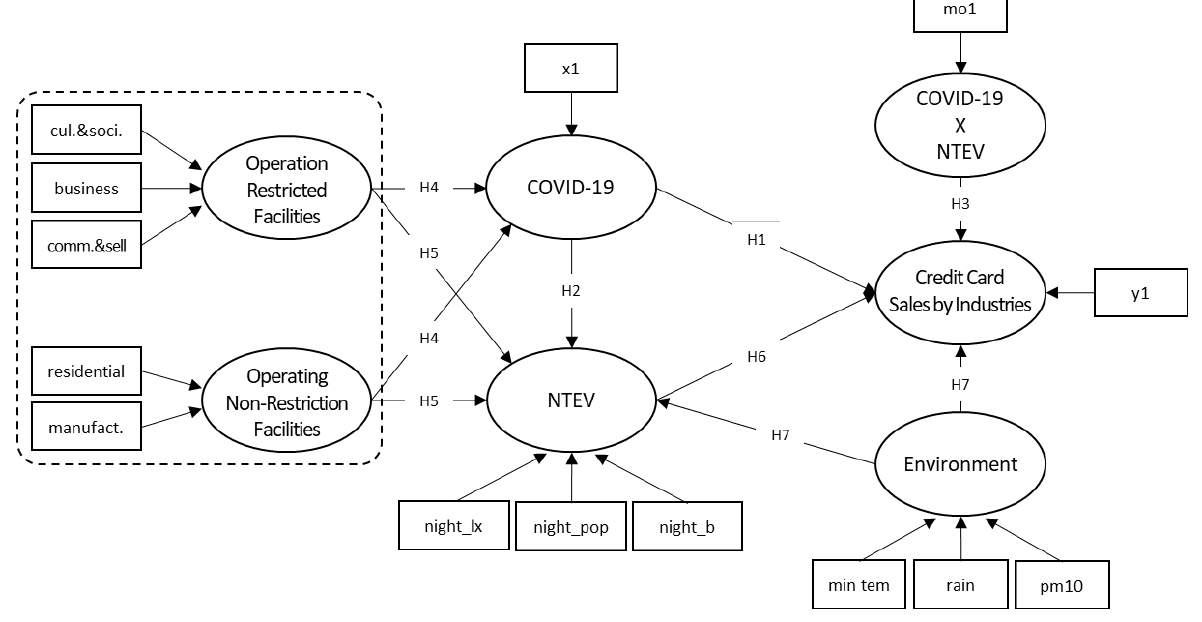
Figure 5. An analysis model used in this study.